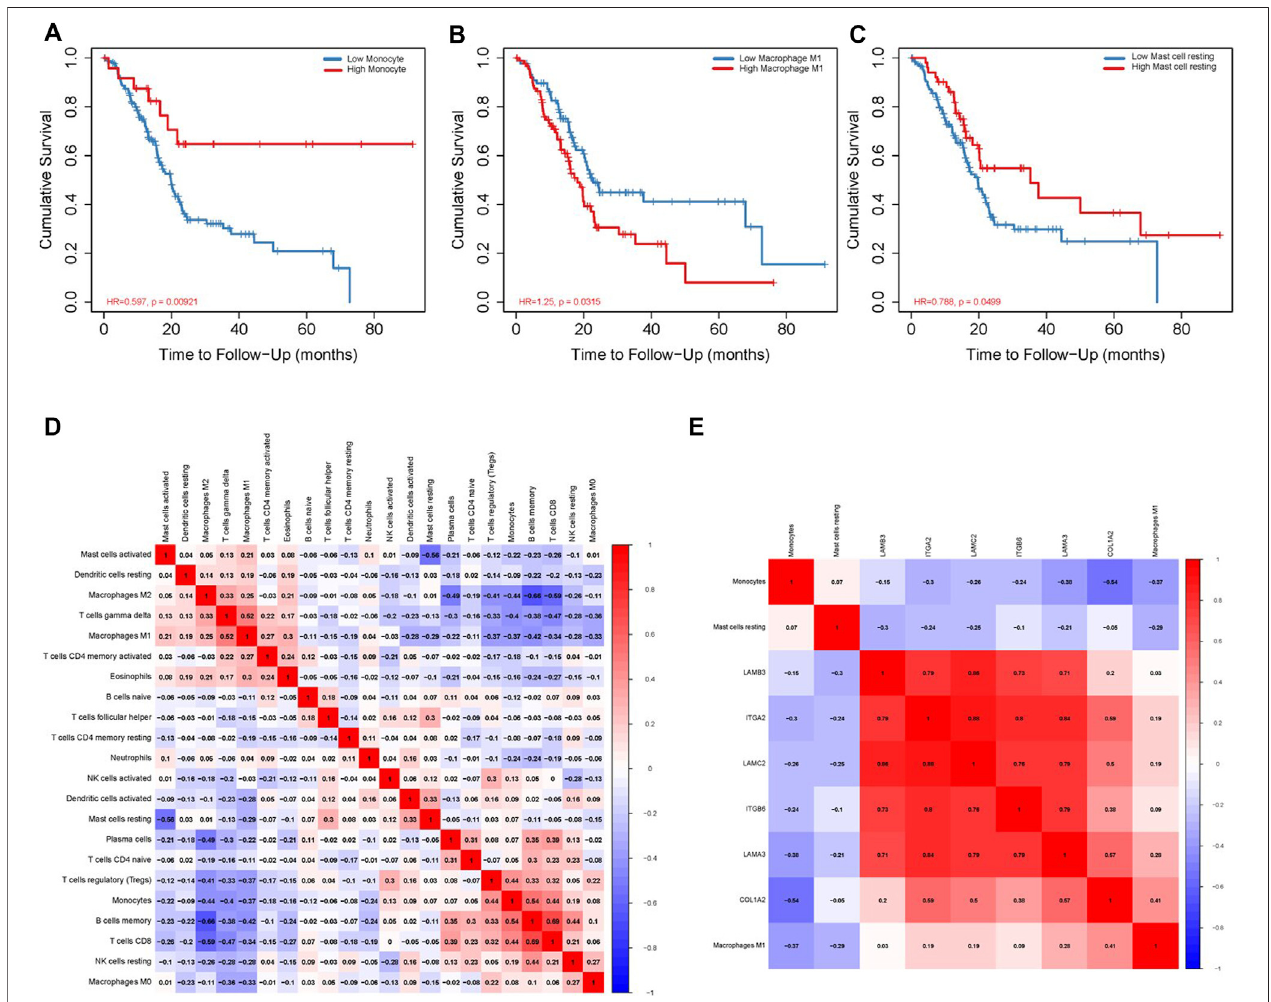
FIGURE11 | Correlation between immunecell fraction and OS (A – C) . Signi fi cant co-expression patterns between proportionsof immune cells (D) . Signi fi cantco- expression patterns between hub mRNAs and immune cells (E)